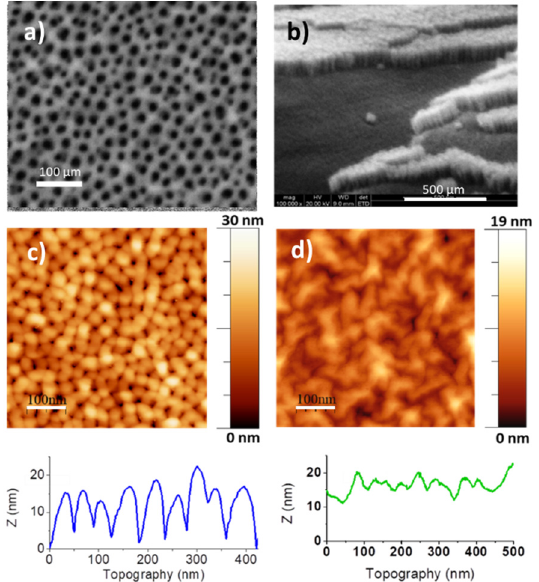
Figure 2. ( a , b ) SEM images of a membrane with pore diameter d ≈ 18 nm and h ≈ 100 nm, ( c , d ) atomic Figure 2. ( a ) and ( b ) SEM images of a membrane with pore diameter d ≈ 18 nm and h ≈ 100 nm, ( c ) force microscopy (AFM) topographic images and height profiles of the pristine membrane and after and ( d ) atomic force microscopy (AFM) topographic images and height profiles of the pristine graphene transfer, membrane and after graphene transfer, respectively.